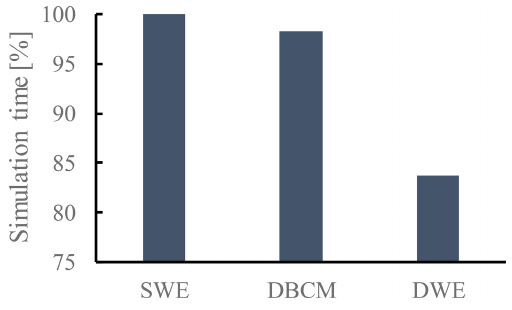
Figure 17. Comparison of water depth profile in the channel